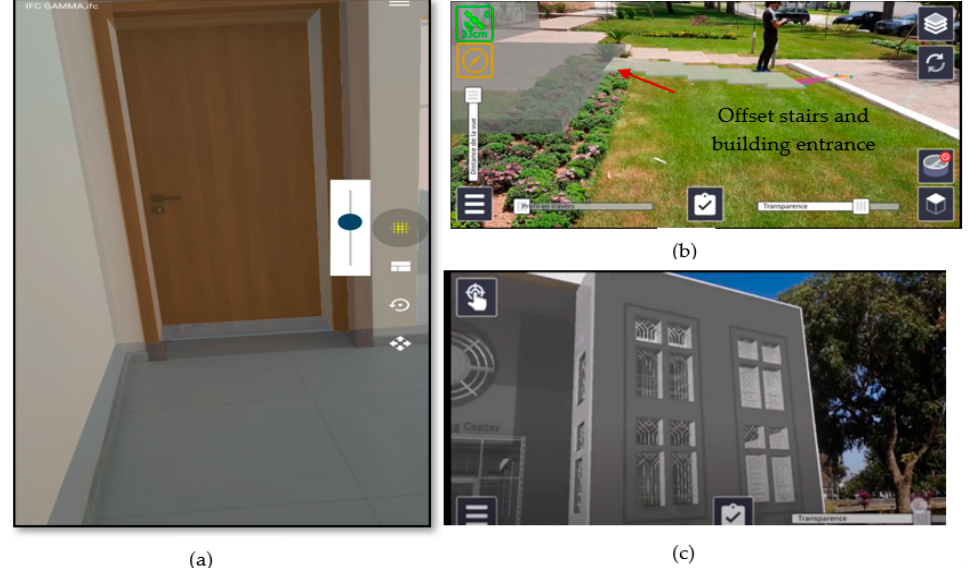
Figure 17. Placement result of the 3D model by ( a ) the GAMMA AR solution in indoor; ( b ) SiteVision solution in outdoor with automatic placement; and ( c ) SiteVision in outdoor in manual placement.